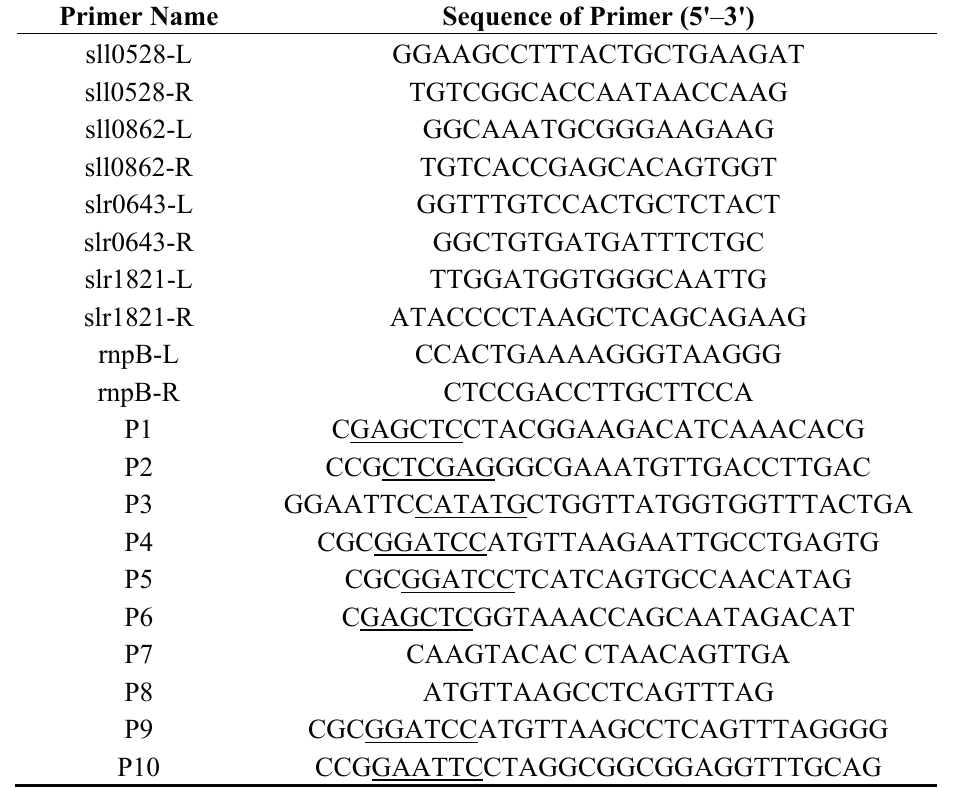
Table 1. Primers used in this research. The restriction enzyme cleavage sites were